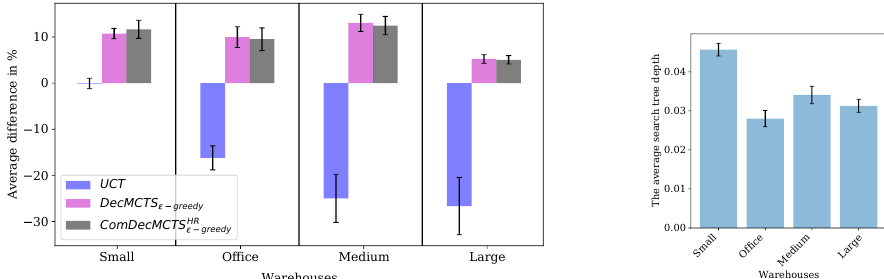
Figure 17. ( left ) The average percentage difference of methods from UCT SA over different warehouse problems. ( right ) The average search tree depth of ComDecMCTS HR standard